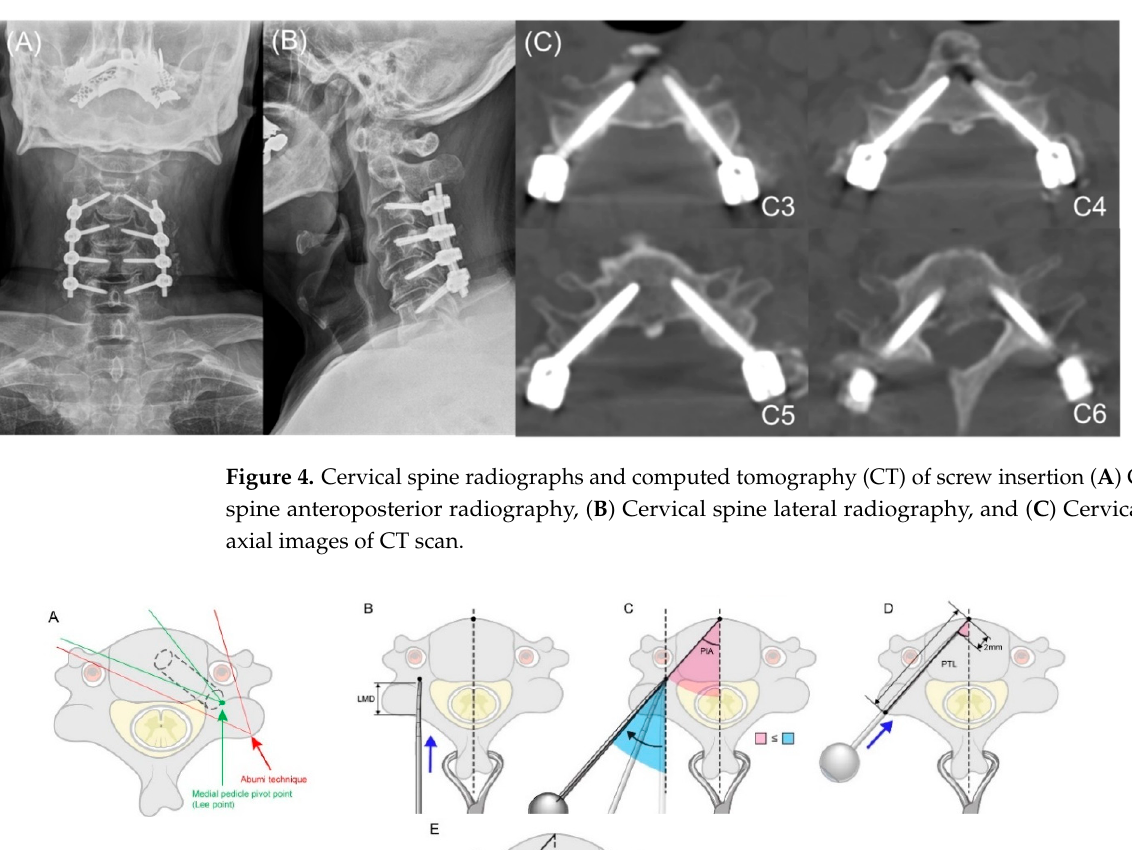
Figure 6. Schematic diagram demonstrating the difference between techniques. ( A ) Position of the patient during the procedure. The head of the patient could be rotated during screw fixation, even when positioned on a Mayfield frame. ( B ) The use of a towel clip to prevent rotation of the vertebra during gearstick probing. ( C ) Use of other techniques may result in a greater likelihood of misplac- ing the gearstick due to unquantified removal of lateral mass, as well as rotation of the vertebra.